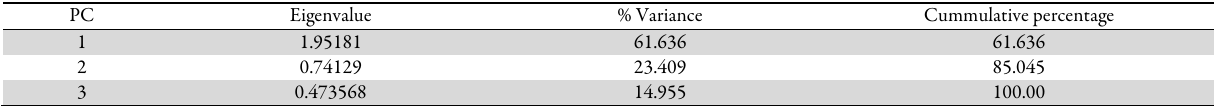
Table 2. Eigenvalue and the percentage of total variation accounted for by the first three components axes of ordination of the Talinum taxa.